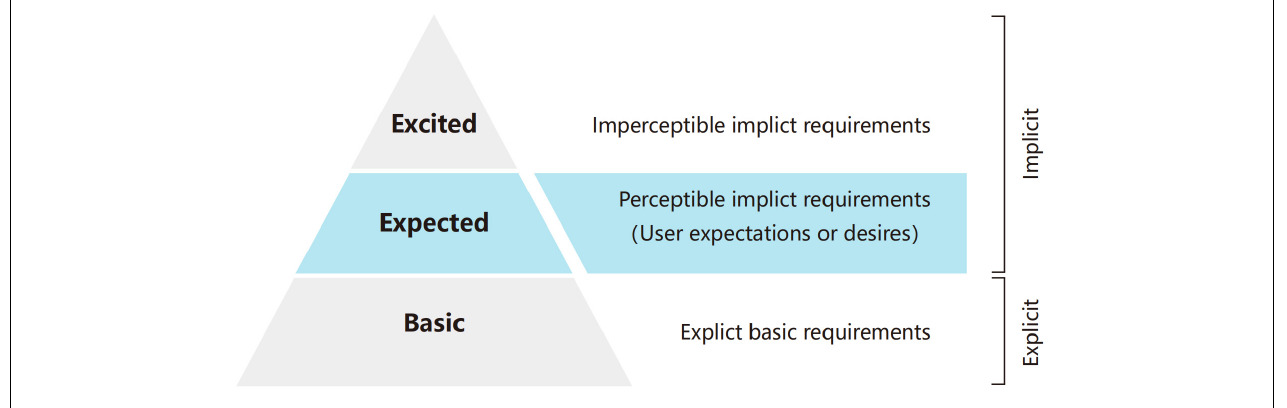
FIGURE 2 | Three layers of user